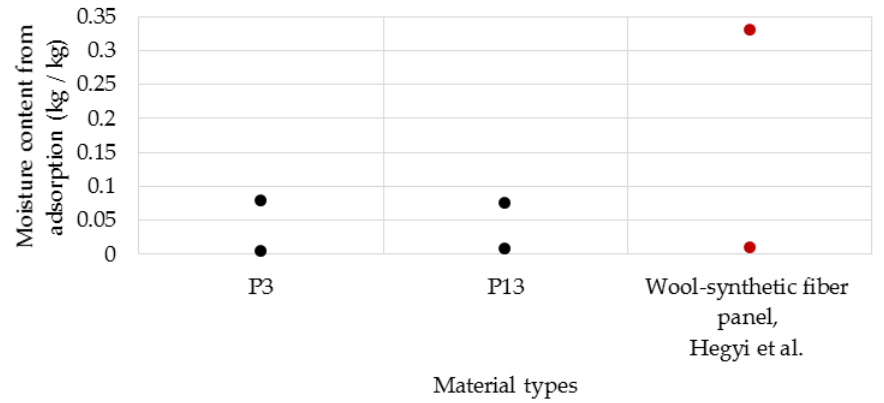
Figure 22. Moisture content from adsorption of samples (data from ref. [53]).